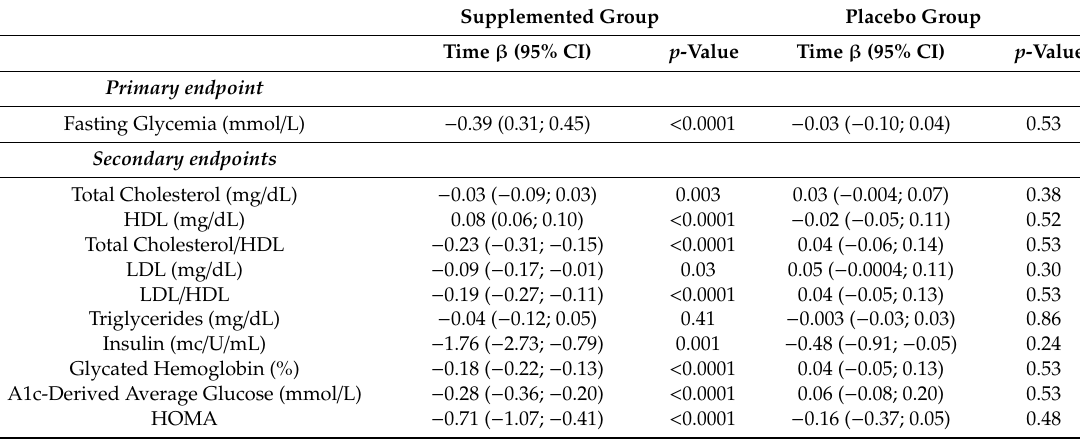
Figure 2. Supplementation e ff ects on glycemia parameters. Bar graphs illustrate the between- and within-group supplementation e ff ect on glycemia parameters. Each graph shows the mean values of the glycemia parameters in the two groups (i.e., supplemented and placebo) in the three di ff erent time points (grey scales), with error bars representing the standard deviation. Triple asterisks indicate a significant di ff erence ( p < 0.0001), double asterisks a significant di ff erence ( p < 0.001), while the single asterisk represents a statistically significant di ff erence ( p < 0.05). Results obtained fitting linear mixed e ff ect models indicate a statistically significant decrease in fasting glycemia, insulin, HMA, glycated hemoglobin and A1c-derived average glucose in the supplemented group, while no statistically significant results (NS) were observed in the placebo group. Statistically significant di ff erences were observed between the two groups for the investigated parameters. Table 4. Within-group pre-post supplementation difference for primary and secondary endpoints. Estimate of time ( β ), 95% confidence interval (CI) and the adjusted p-value of the null hypothesis of a no effect are reported for the two groups.